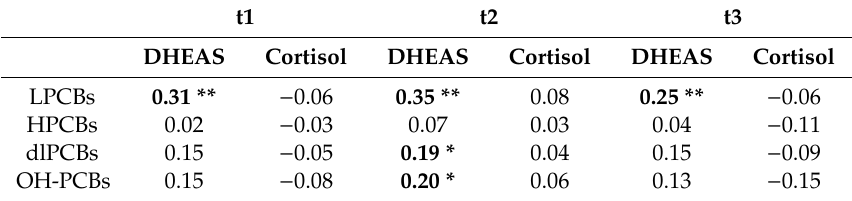
Table 3. Cross-sectional Spearmans’ rank correlation coe ffi cients between the PCB variables and DHEAS and cortisol ( N = 112). t1 t2 t3 DHEAS Cortisol DHEAS Cortisol DHEAS Cortisol LPCBs 0.31 ** − 0.06 0.35 ** 0.08 0.25 ** − 0.06 HPCBs 0.02 − 0.03 0.07 0.03 0.04 − 0.11 dlPCBs 0.15 − 0.05 0.19 * 0.04 0.15 − 0.09 OH-PCBs 0.15 − 0.08 0.20 * 0.06 0.13 −